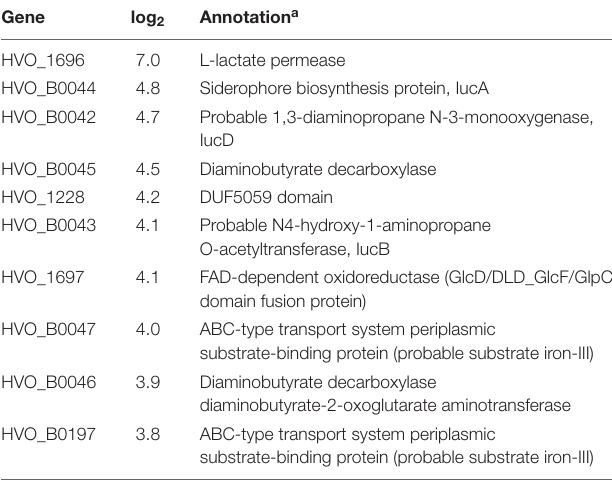
TABLE 2 | Genes up-regulated in the endA CRISPRi